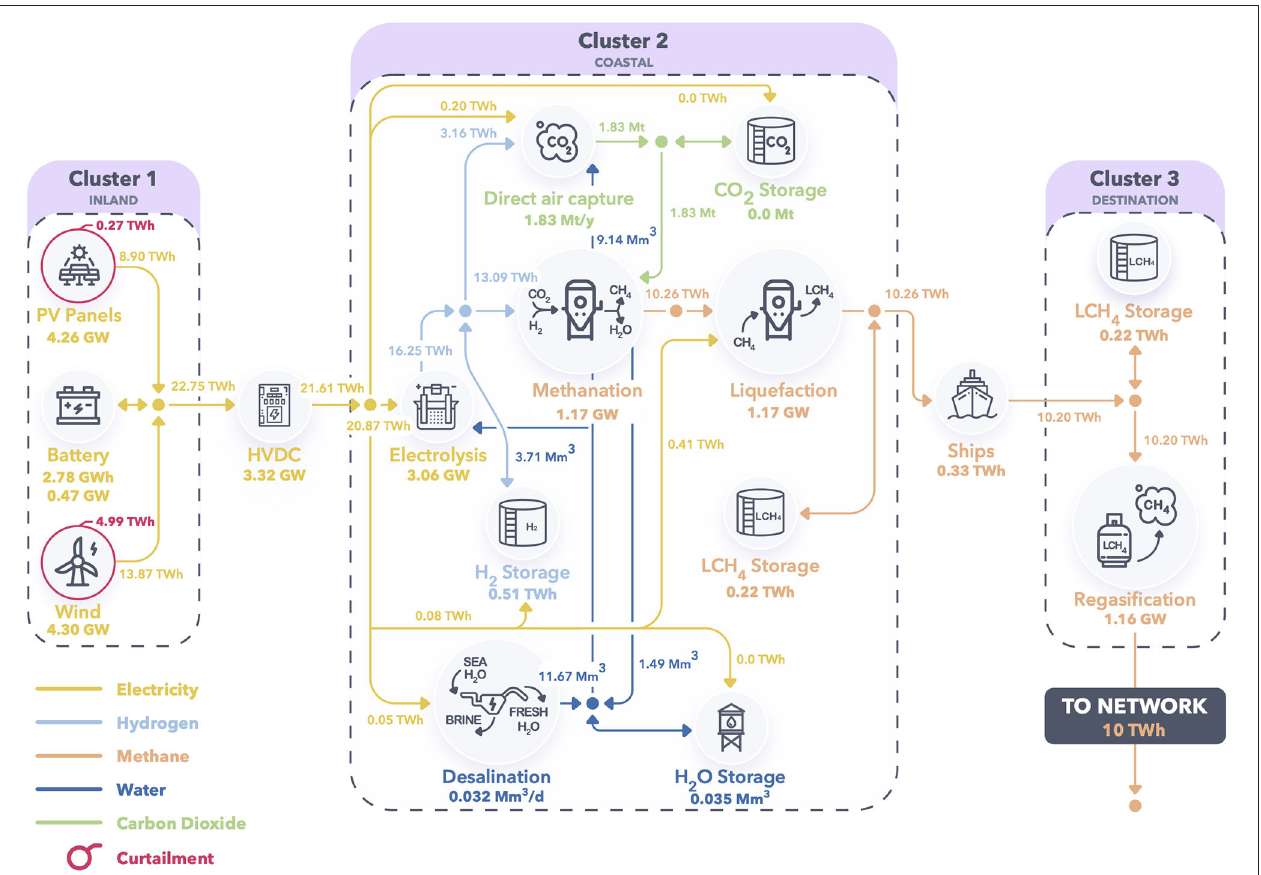
FIGURE 7 | Material and energy balance diagram for the reference scenario, along with technology capacities. All energy-equivalent flows of energy carriers other than electricity were computed using their HHV. Flow values represent yearly averages (i.e., flows were integrated over the full time horizon and divided by the number of years) and all values were rounded up to keep significant digits